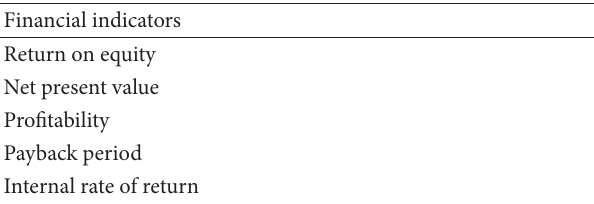
Table 2: Financial assumptions and indicators.